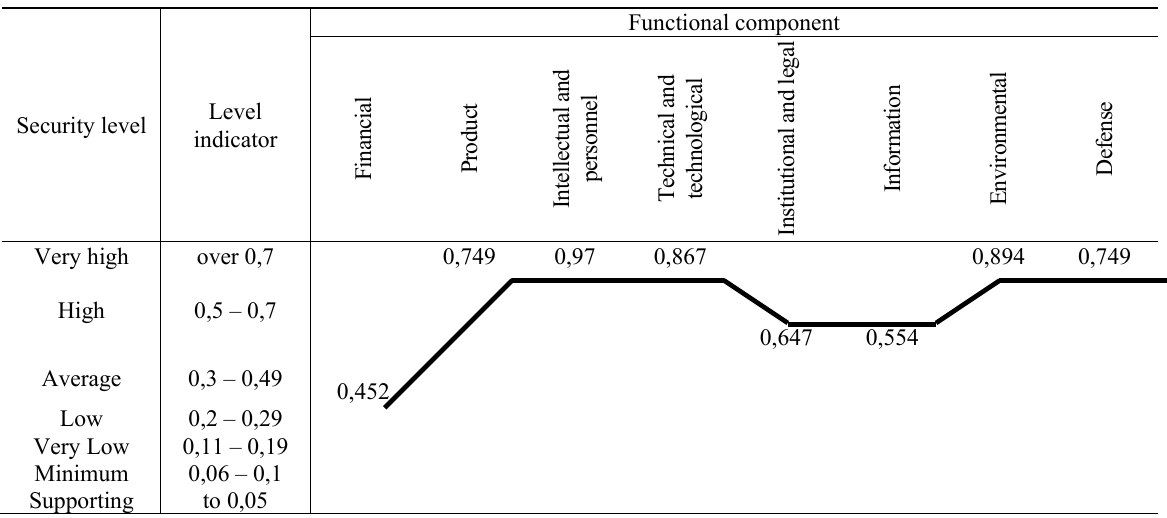
Fig. 2. Characteristics of the levels of functional components of economic security of the MCEOE